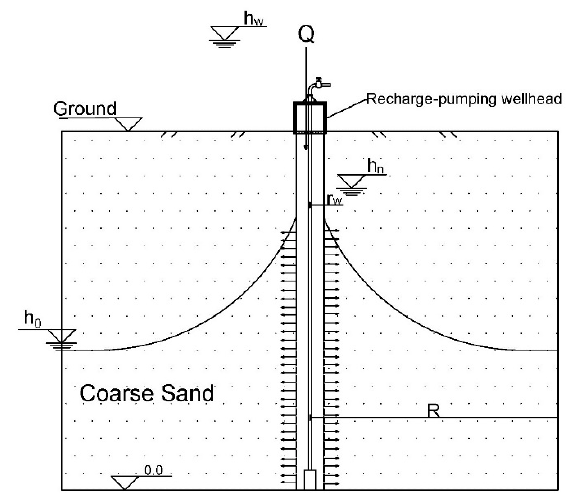
Figure 3. Steady-flow recharge model of the recharge-pumping well.